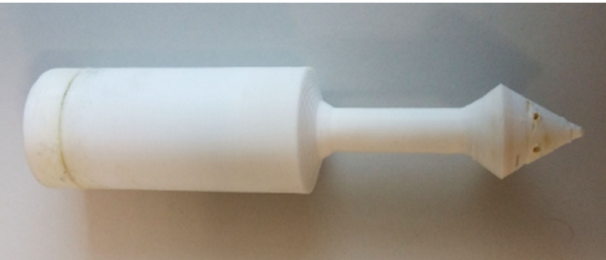
Figure 10. Photo of the PP reactor after the 15th reactor cycle (the reactor was used in 15 successive